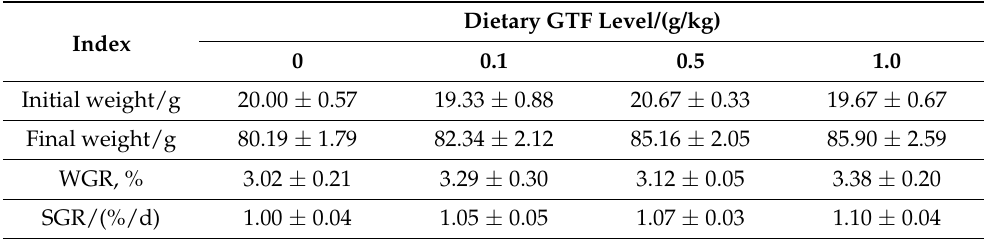
Table 2. Effects of dietary GTF level on growth indices of